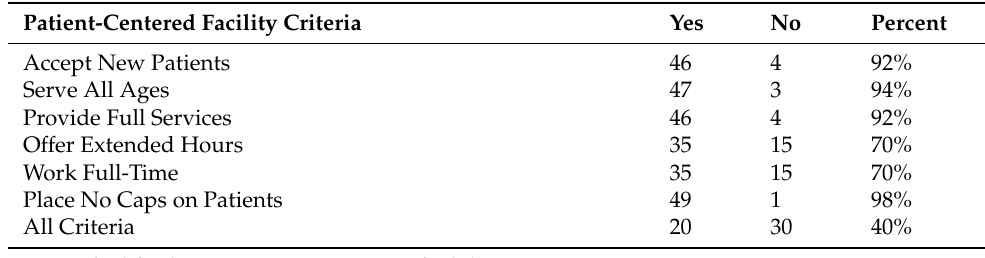
Table 6. Dental facilities fulfilling patient-centered